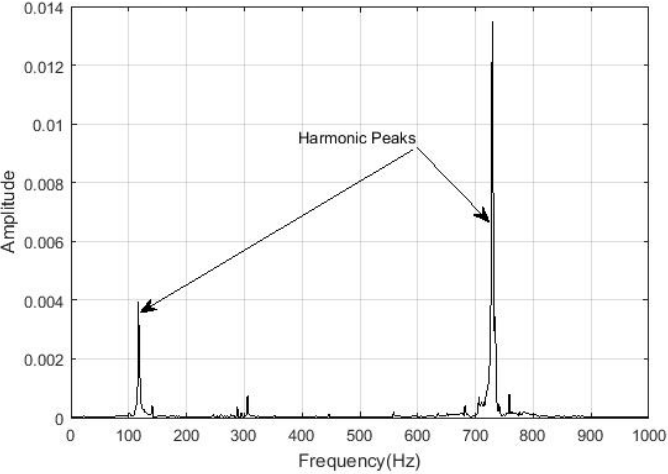
Figure 17. Spectrum of the two broken bars, in relative position 1–5, signal after the noise reduction with the harmonic peaks.